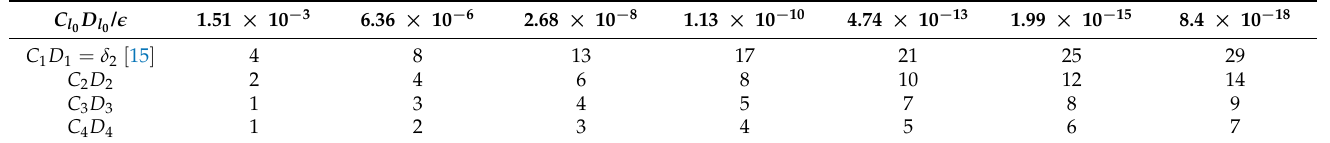
Table 7. Depth of the 4-point approximating QSS surface model.